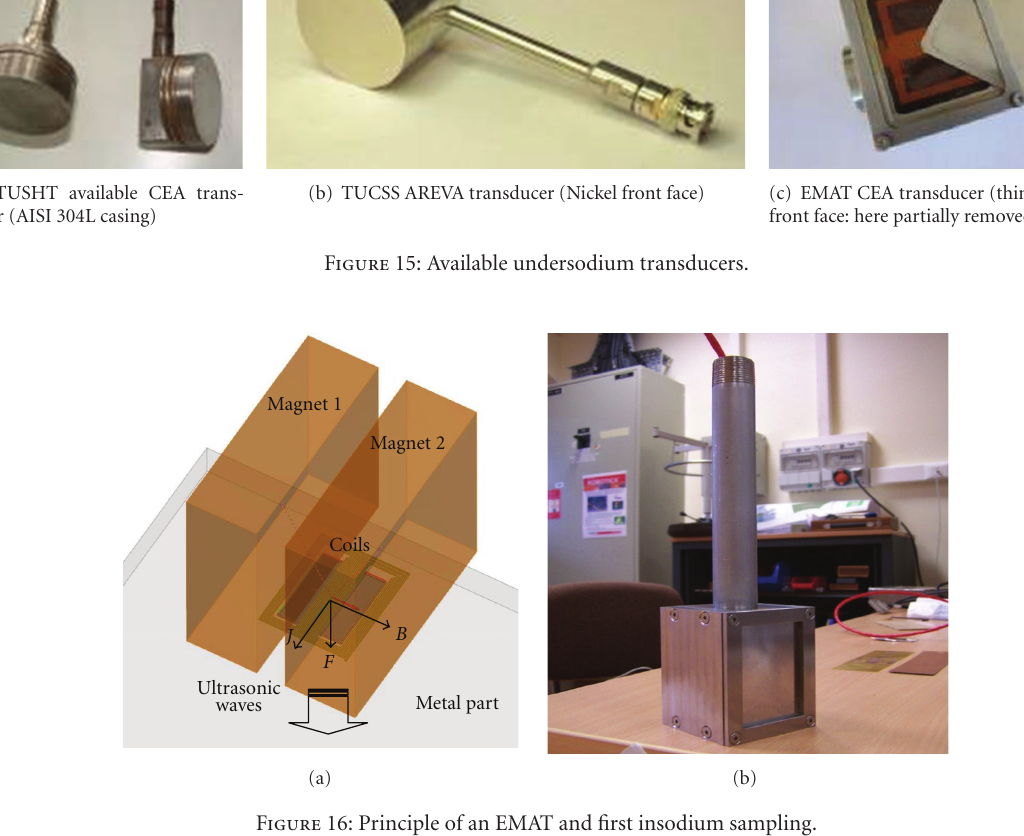
Figure 16: Principle of an EMAT and first insodium